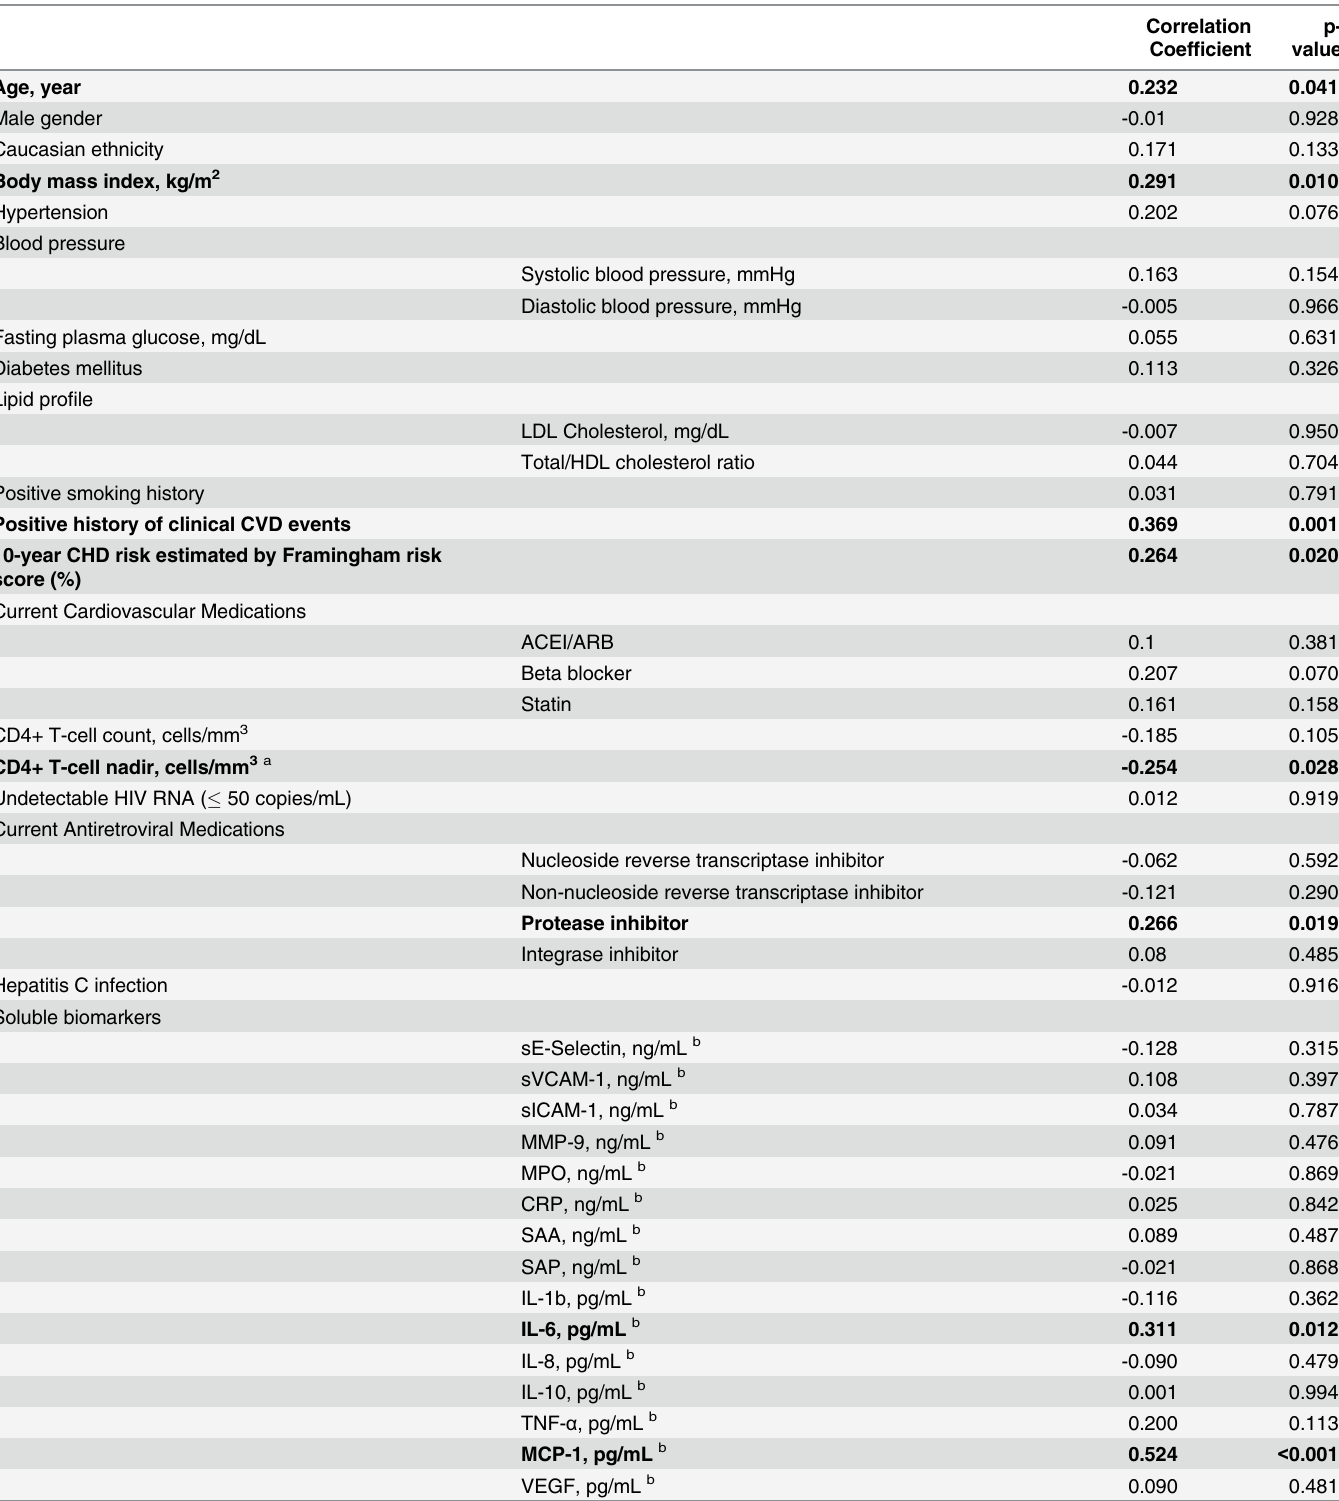
Table 2. Spearman ’ s correlation for 2-year coronary artery calcium (CAC) Agatston score